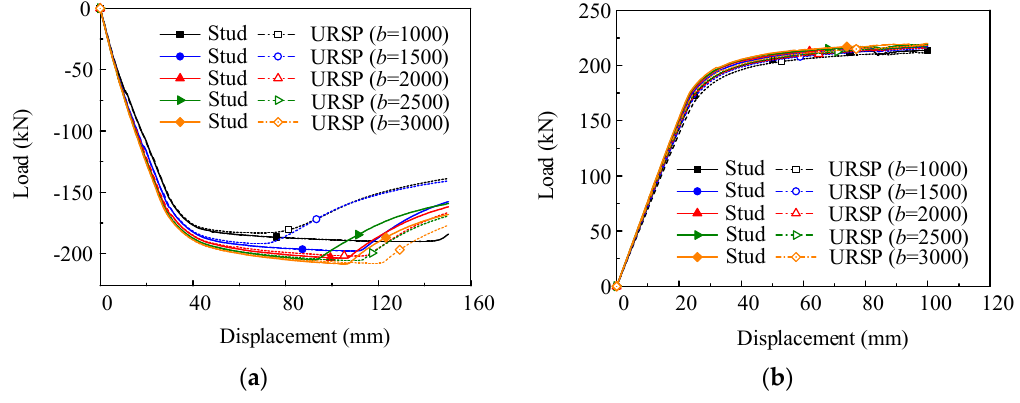
Figure 14. Load-displacement curves with different slab widths b . ( a ) Hogging moment; ( b ) sagging moment.